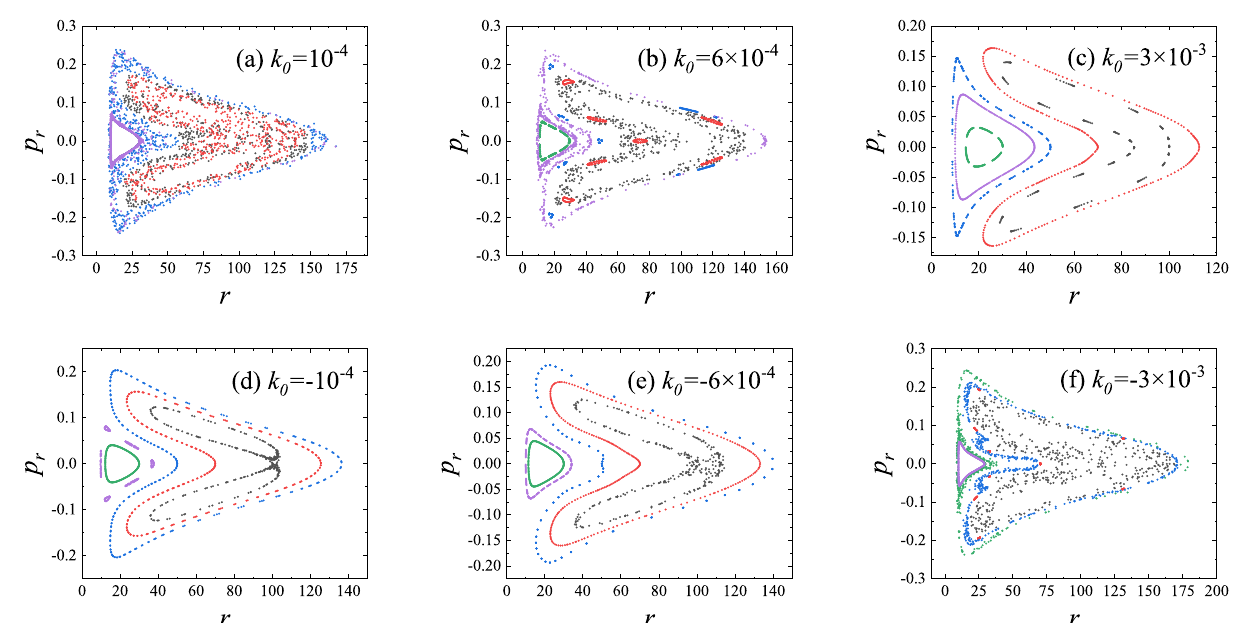
Figure 7. Poincaré sections for different values of the deformation parameter k 0 . The parameters are L = 4.6, Q = 8 × 10 − 4 , k 1 = 10 − 2 , k 2 = 10 − 1 and k 3 = 1. ( a – c ): E = 0.995 and k 0 > 0. The strength of chaos is weakened with increasing k 0 . ( d – f ): E = 0.994 and k 0 < 0. Chaos is enhanced as | k 0 | increases.